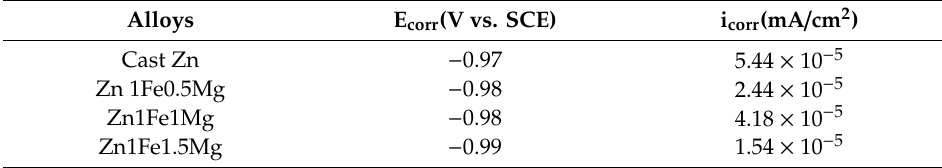
Figure 5. Potentiodynamic polarization analysis of tested Zn alloys in simulated body fluid (SBF) solution at ambient temperature. Table 3. Fitted results of polarization curves in Figure 5: Ecorr is Corrosion Potential; icorr is corrosion current density; C.R is the corrosion rate.